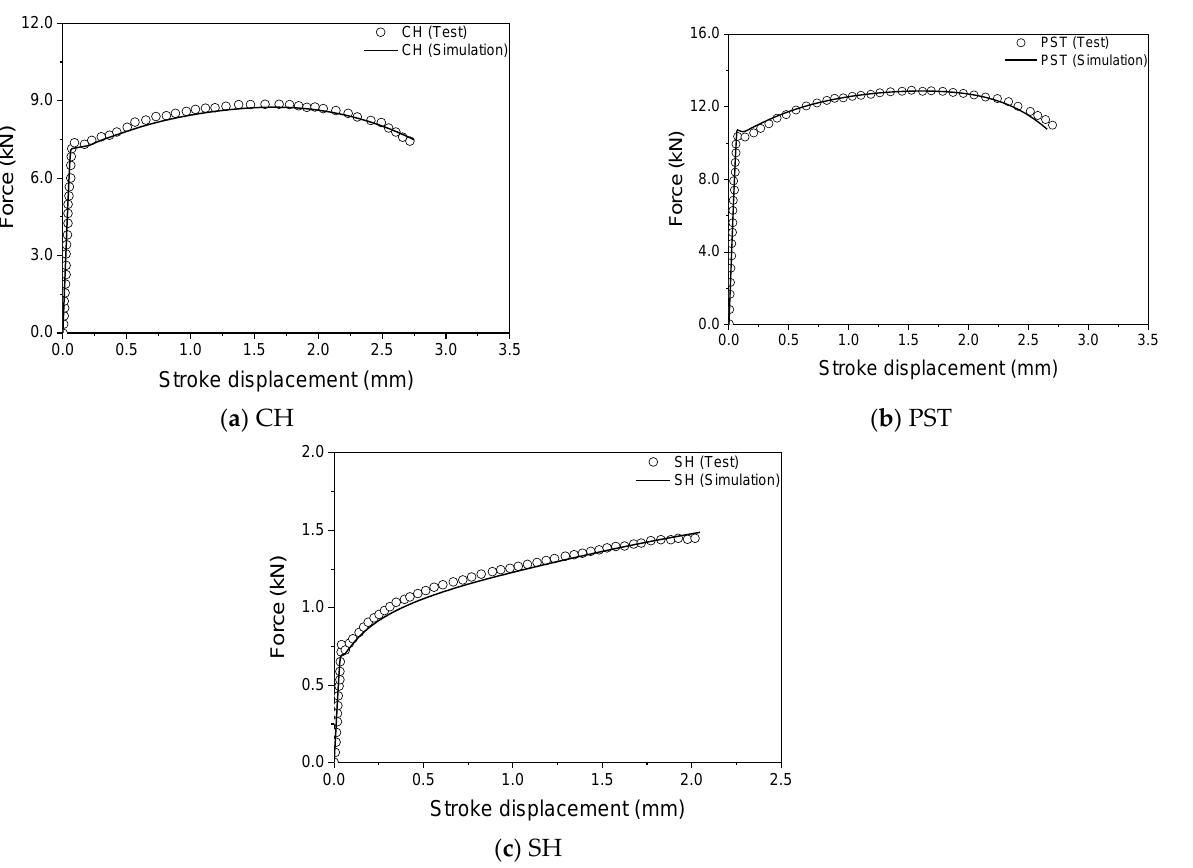
Figure 9 shows the variation in the stress state parameters with increasing equivalent